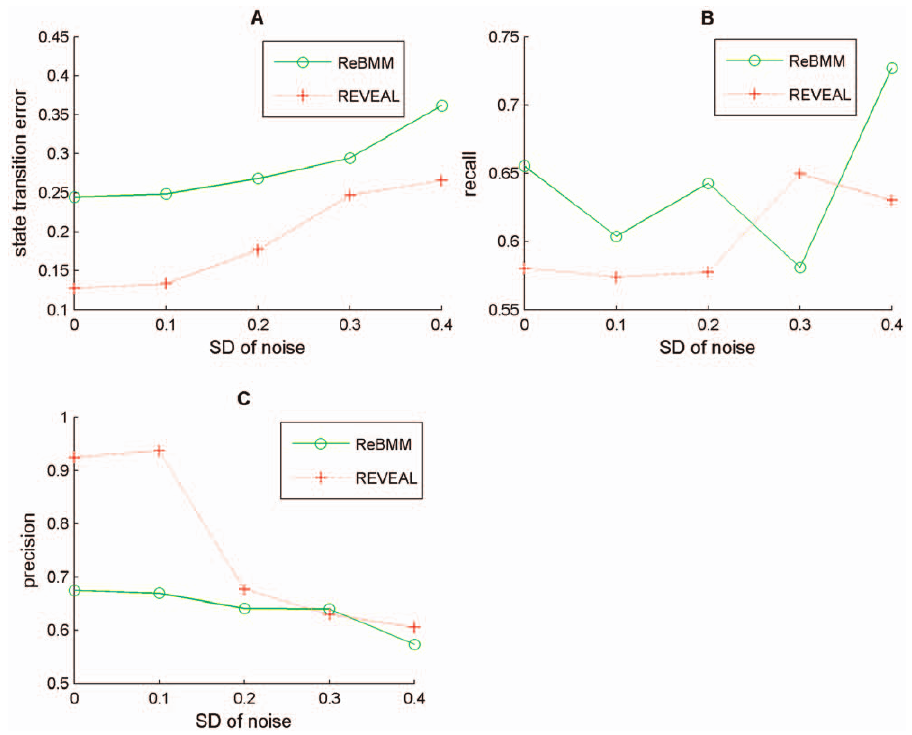
Figure 8. Comparison of REVEAL and ReBMM using different measures. Figure A compares noise vs. state transition error, Figure B is a plot of noise level vs. recall for the two methods and Figure C indicates the noise level vs. precision. Noise level is the standard deviation s of Gaussian distribution with zero mean. The total simulations in all experiments is 5 and the indegree for REVEAL is 4.